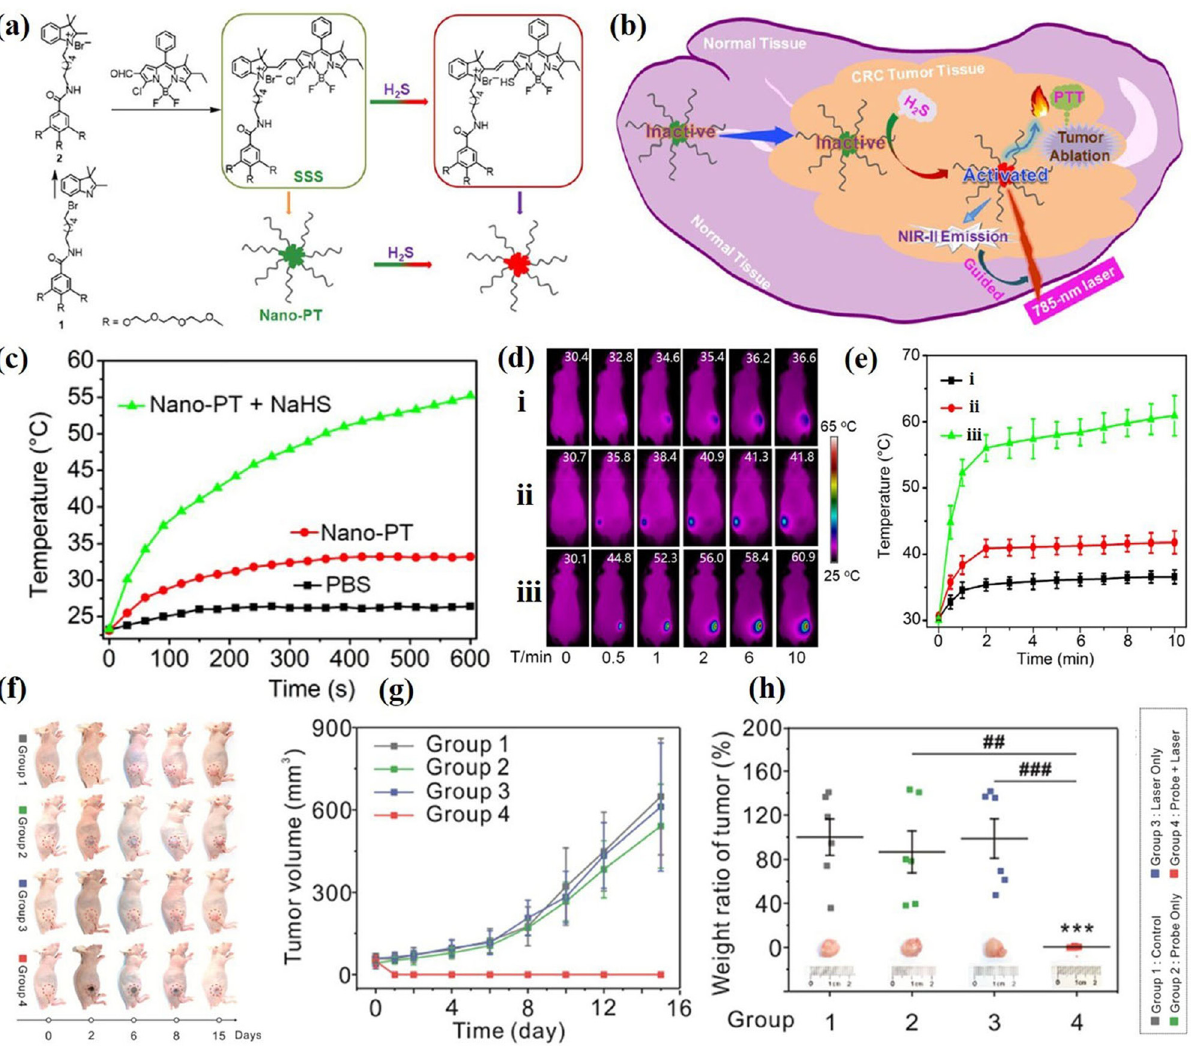
Figure 9: ( a ) Synthesis of SSS and its conversion into a NIR - triggered photothermal agent. ( b ) An illustration of the action of photothermally active Nano - PT for NIR - II fl uorescence - guided colorectal cancer therapy. ( c ) Temperature changes of PBS and Nano - PT ( 20 μ M ) with or without NaHS ( 100 μ M ) under 785 nm laser irradiation ( 5.37 W cm − 2 ) . ( d and e ) Infrared thermal images of HCT116 tumor - bearing mice under NIR laser irradiation: ( i ) no probe administered; ( ii ) probe - administered in normal tissue; ( iii ) probe - administered in tumor tissue. ( f ) Photographs of grouped mice during PTT. The tumor location was represented by red circles. ( g ) The curves of tumor growth in di ff erent treatment groups. ( h ) Ratio between tumor weight and photographs of extracted tumors on day 15. Reprinted with permission from Ref.